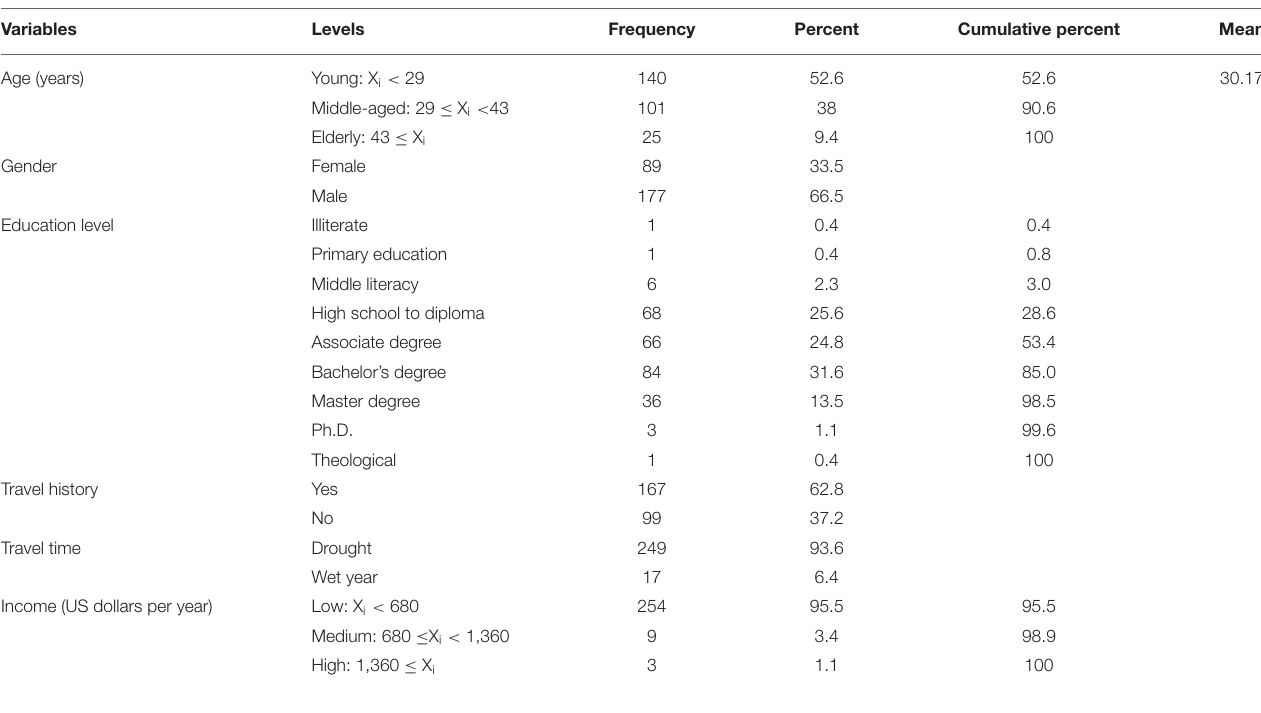
TABLE 2 | Descriptive statistics of individual and professional characteristics.